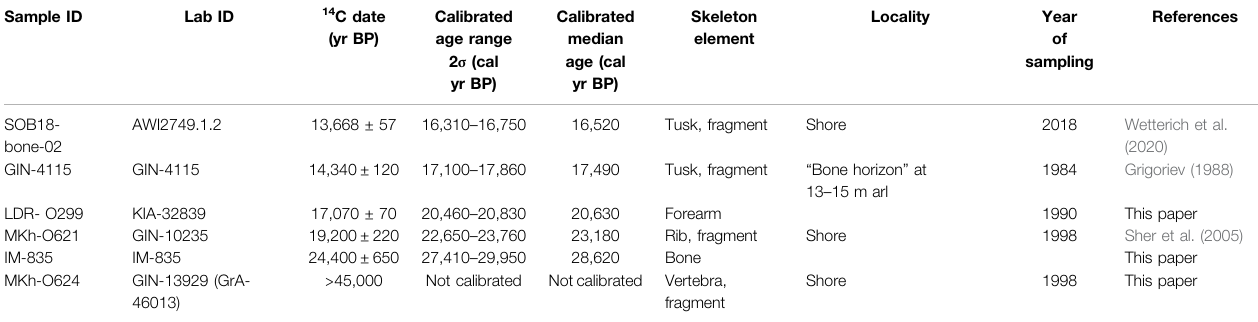
TABLE 2 | Radiocarbon ages of Mammuthus primigenius bone fragments from Sobo-Sise Island (Eastern Lena Delta) calibrated using CALIB REV8.2 (Reimer et al., 2020). Results are rounded to the nearest 10 yr for samples with standard deviation in the radiocarbon age greater than 50